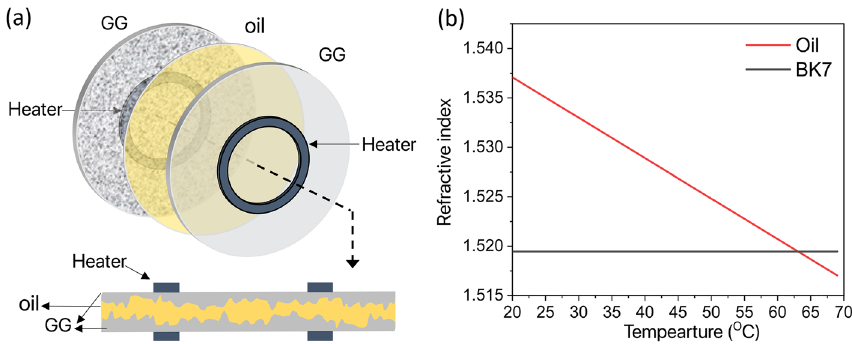
Figure 2. Tunable phase screen (TPS). ( a ) Schematic and cross-sections of TPS comprising two similar ground glasses (GG), a thin layer of refractive index oil, and two ring-shape heaters. ( b ) Change of the refractive index of the oil as temperature increases in comparison to the refractive index of glass (BK7) at λ = 532